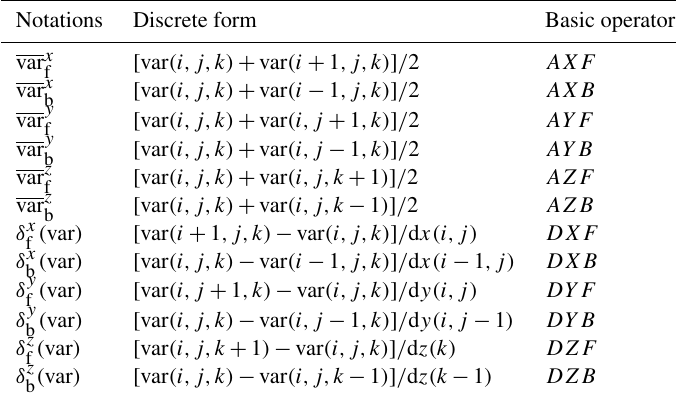
Figure 1. Arrangement of variables in the staggered Arakawa C grid. Table 1. Definitions of the 12 basic